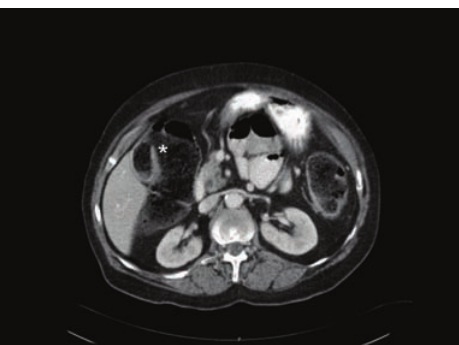
Figure 3: Follw-up abdominal CT scan showing a cholecystocolonic fistula with faeces in the gallbladder (asterisk).